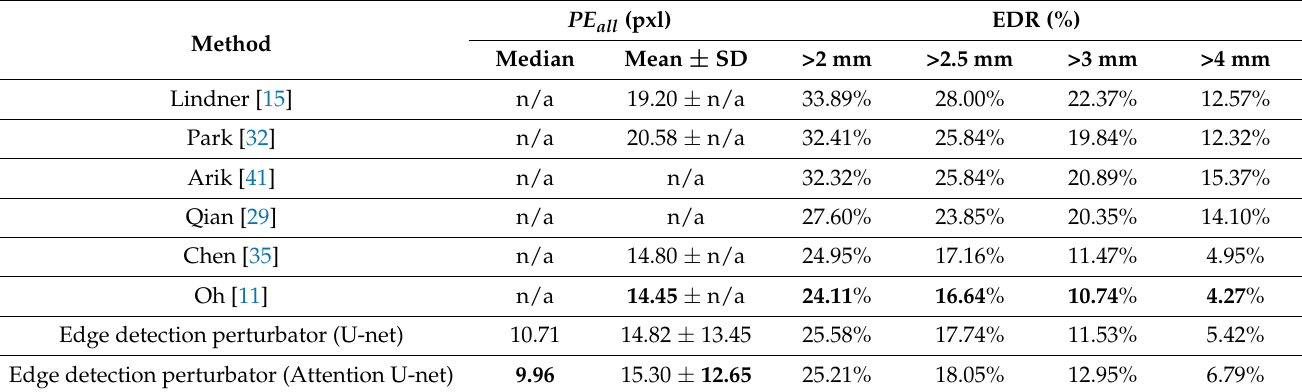
Table 7. Quantitative comparison with existing methods on the ISBI 2015 dataset (test2).